Question: Provide a one-line summary of what is displayed.
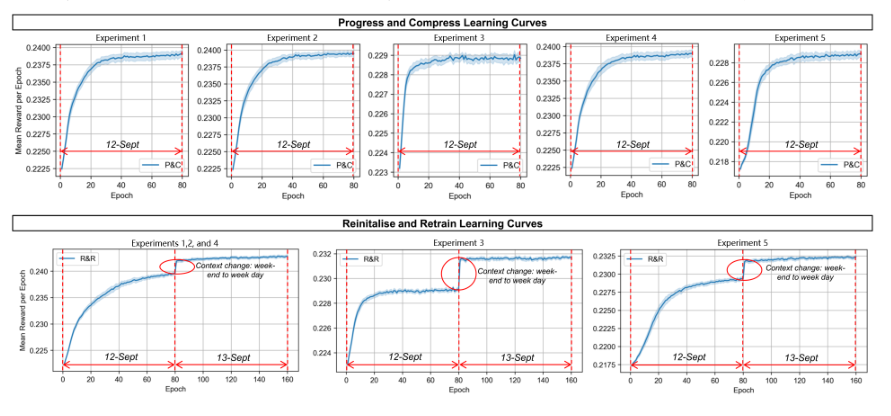
Answer: Learning curves. Blue shading shows standard deviation over 20 independent runs.